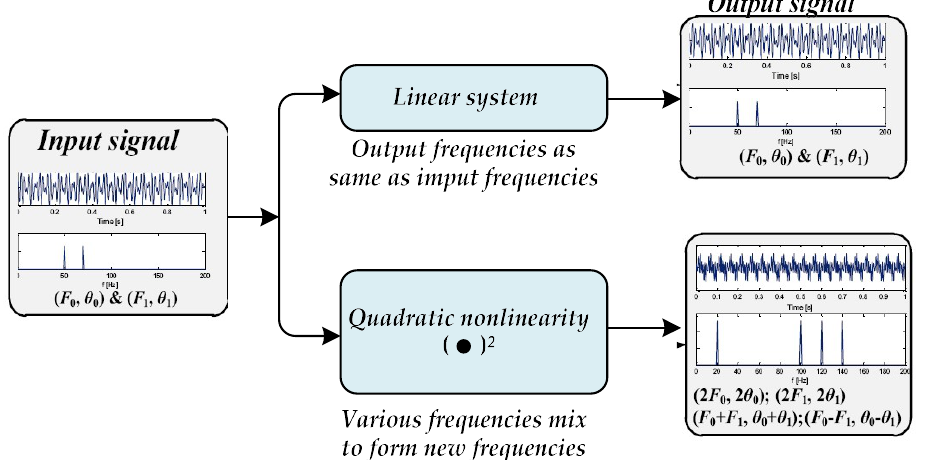
Figure 5. Diagram indicating the quadratically nonlinear interaction (NIT) between frequency components F 0 and F 1